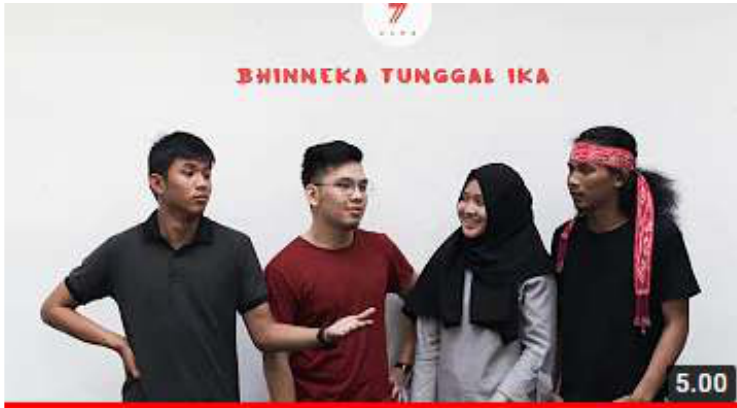
Figure 1. Youtube video entitled "Bhinneka Tunggal Ika" Source: